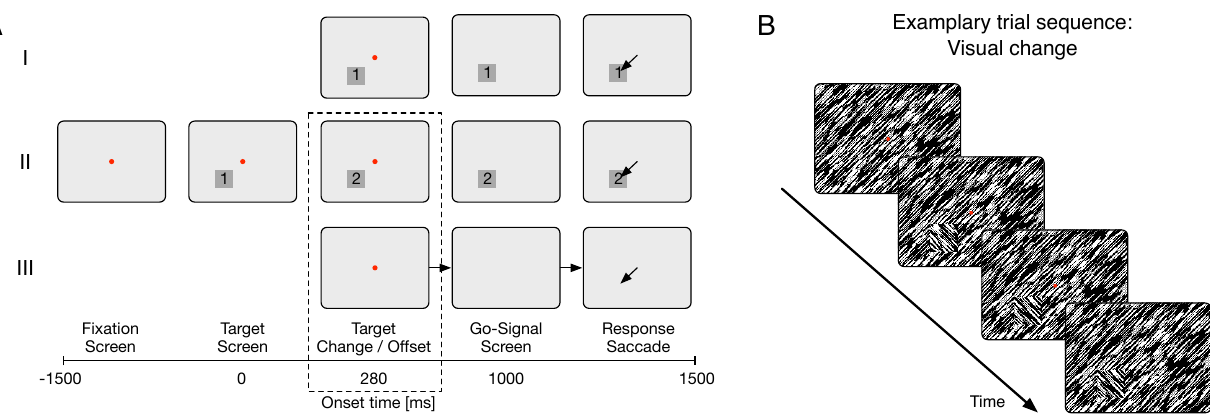
Figure 2 . Illustration of the experimental procedure in the delayed-saccade task. A Sequences of visual stimulation in the three conditions (I = Visual static; II = Visual change; III = Memory). B Example of a display sequence in the Visual change condition. Note, that the target square changes its appearance from the second to the third screen, while the background remains the